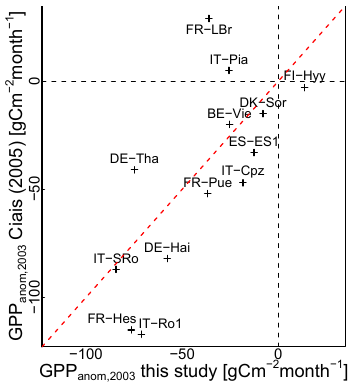
Figure 2. Conceptual overview of the different data streams and successive steps of our